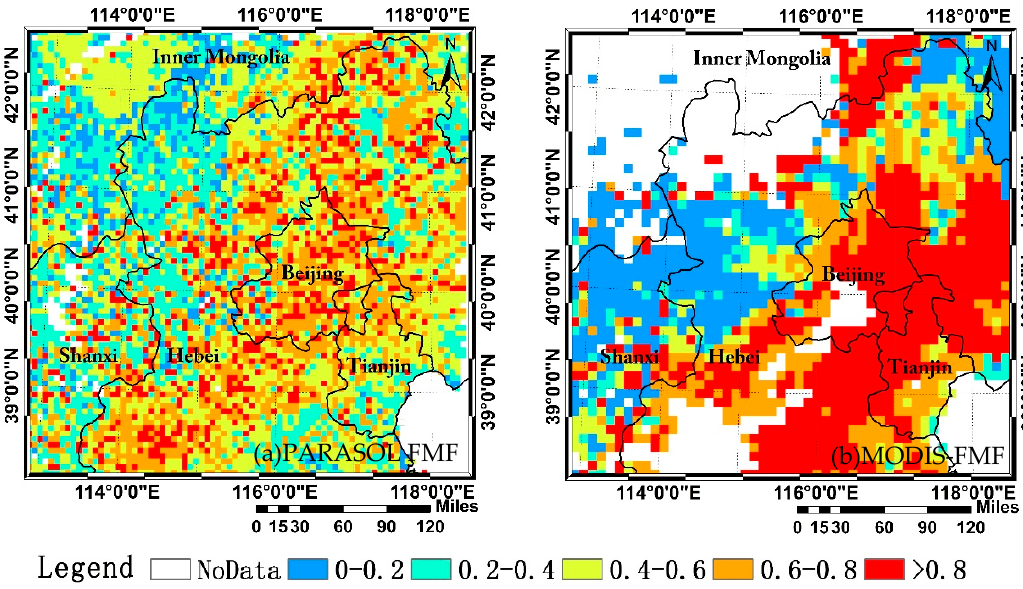
Figure 6. The comparison of the FMF retrieval results of PARASOL and MODIS FMF products for 5 October 2013. ( a ) is the FMF result of this work, and ( b ) is the FMF result of MODIS.